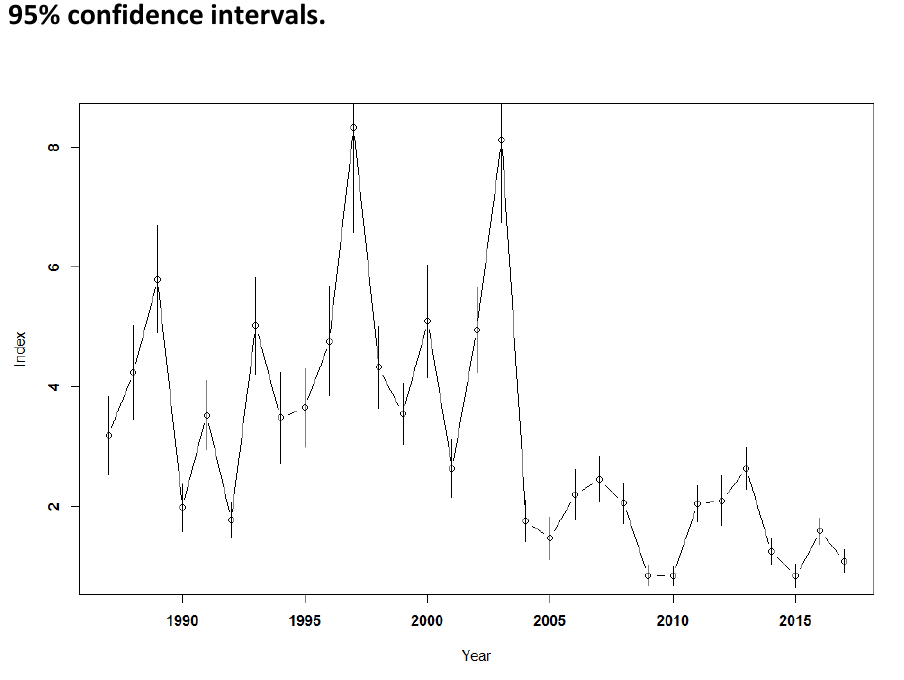
Figure 38. Index of relative abundance of horseshoe crab (delta mean catch per tow) in Manhassett and Little Neck Bays developed from the spring portion of the New York Seine Survey with 95% confidence